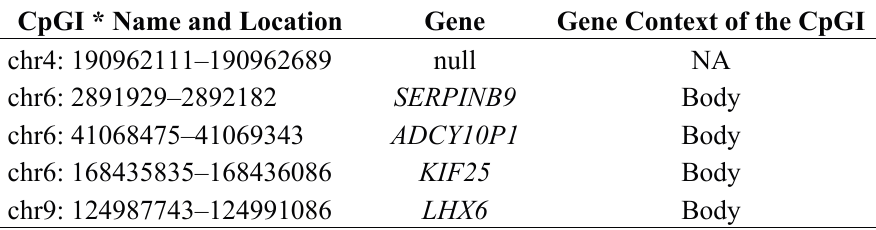
Table 3. CpGIs in the subset analyzed using ordinary least squares (OLS) linear regression